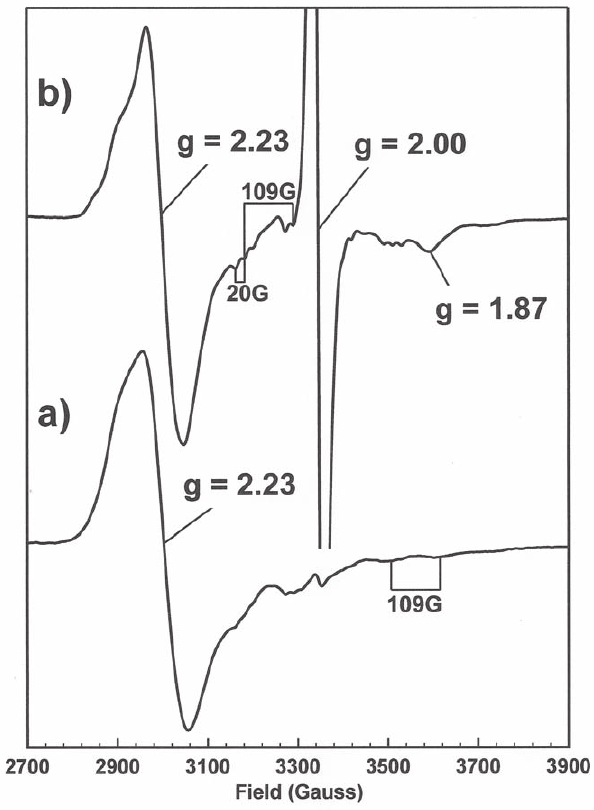
Figure 4. X-band EPR spectra of hydroxocobalamin and NADH in the absence, a), and presence, b), of PduS. Experimental conditions: microwave power 0.5 mW, modulation amplitude 5 G, modulation frequency 100 KHz, temperature